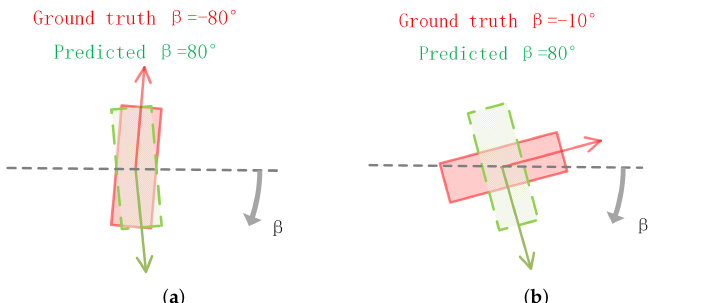
Figure 7. ( a ) The case where the angle loss function used in AVOD may encounter problems. ( b ) The case where the angle loss function used in SECOND may encounter problems. We use red solid box to denote the ground truth box and green-dotted box to denote the predicted box.